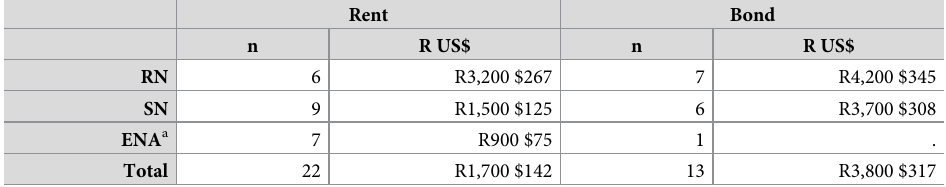
Table 6. Median monthly housing expenditure, in rand (U.S. dollars at